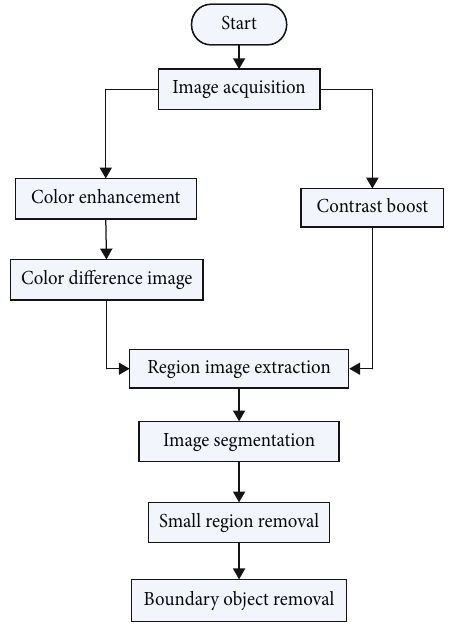
Figure 4: Medical image segmentation process.